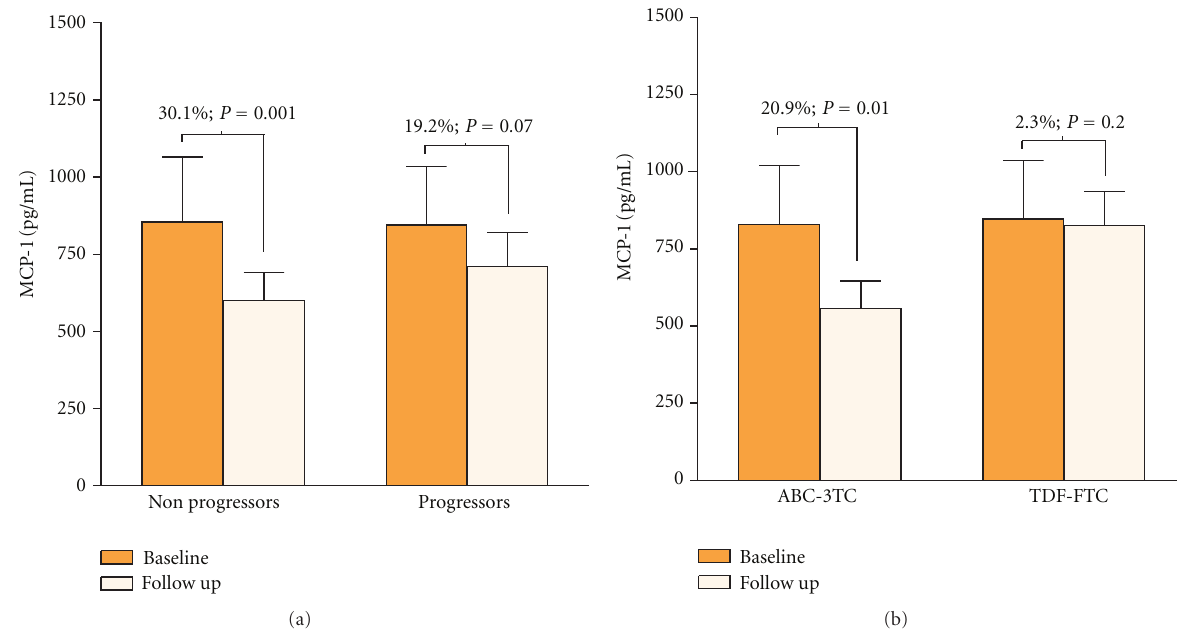
Figure 2: Changes in plasma concentration of MCP-1 after two years of followup in HIV-infected patients. A decrease in plasma MCP- 1 concentration was observed in all HIV-infected patients, though it was more prominent and significant in those who did not display progression of atherosclerosis (a). Stratification according to antiretroviral treatment strategy (b) revealed that the decrease in plasma MCP- 1 concentration was not significant in patients receiving